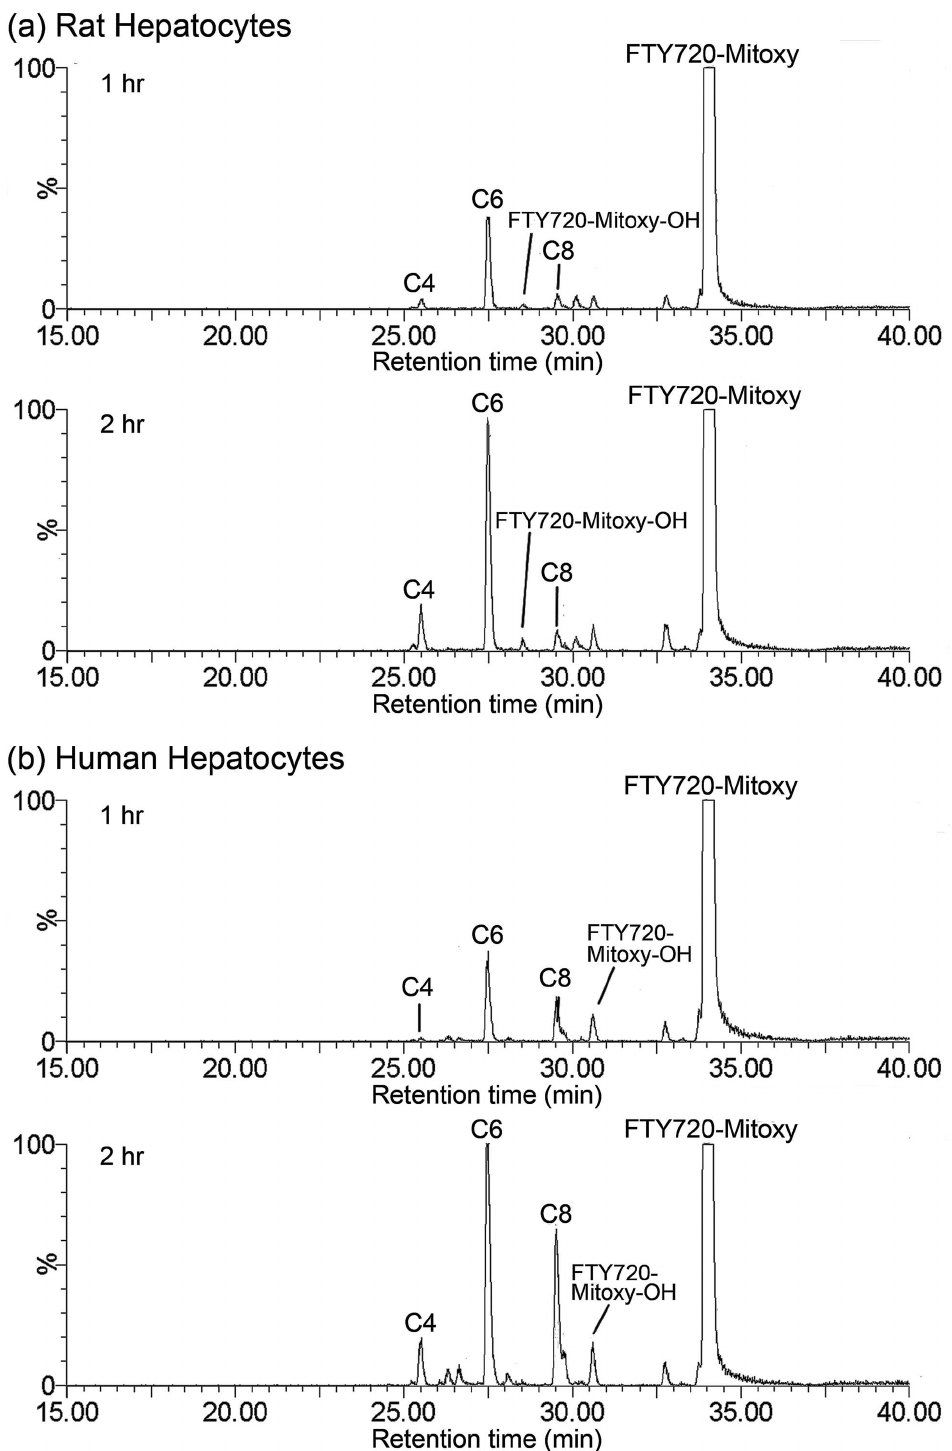
Fig 3. Representative LC/MRMChromatogram of FTY720-Mitoxy Metabolite Profile. Using 1 μ M of FTY720-Mitoxy, we incubated rat (a) and human(b) hepatocytes to obtainmetaboliteprofiles.To simplify presentation, the 0 min incubation timepoint data are intentionally not shown. Legend: C4 , FTY720-Mitoxy C4-carboxylic acid; C6 , FTY720-Mitoxy C6-carboxylic acid; C8 , FTY720-Mitoxy C8-carboxylic acid; FTY720-Mitoxy-OH , hydroxy FTY720-Mitoxy.